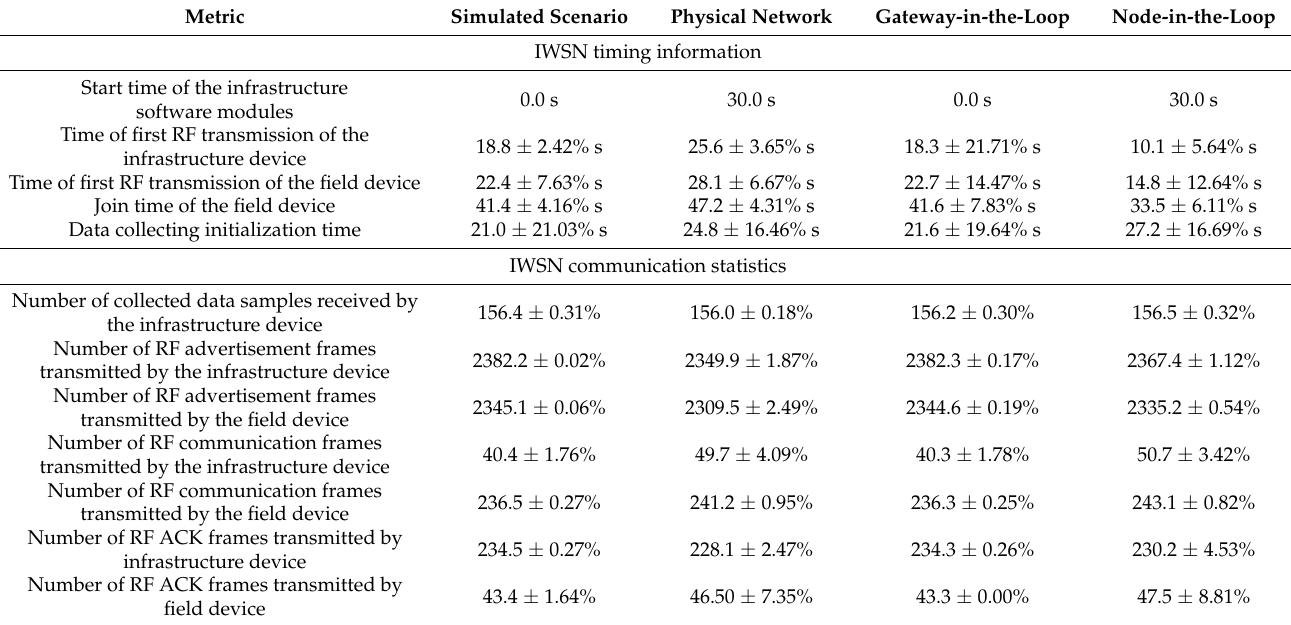
Table 5. Relative standard deviations of the evaluated